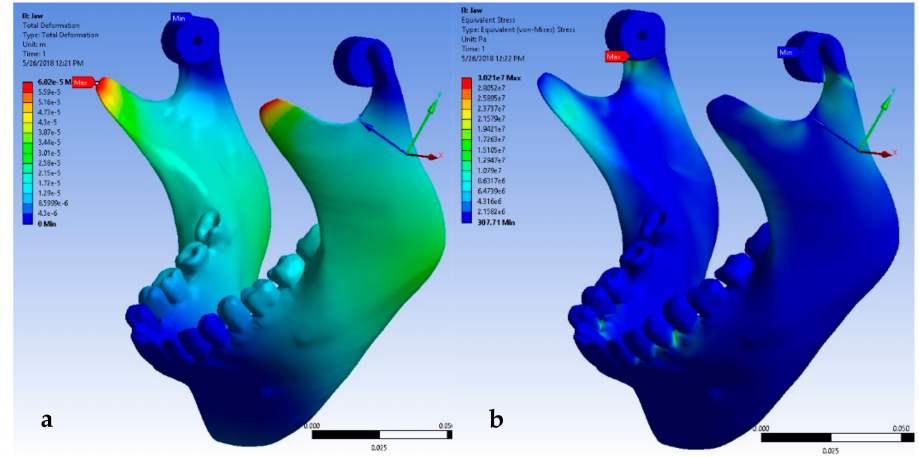
Figure 5. Mandible deformation ( a ) and Von Mises jaw stress ( b ) caused by a frontal bite from an item with rigidity of 2 × 10 12 N/m 3 : the coronoid process’s extremity had the most deformations; the condylar process and the front portion of the mandible had the least amount of deformation. Additionally, there were high stress values in the region of the gap between the lower premolars. 30.21 MPa was the maximum stress value (von Mises stress).